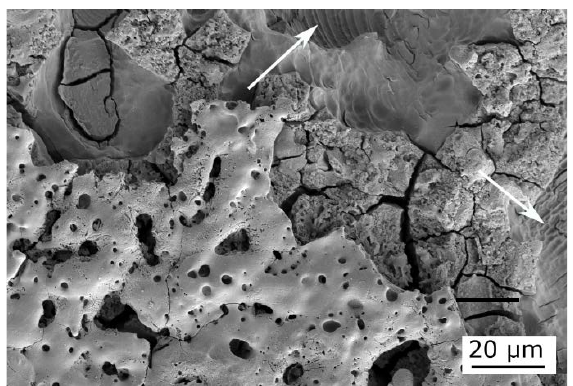
Figure 13. PEO coating after 168 h of exposure in 0.1 M NaCl .